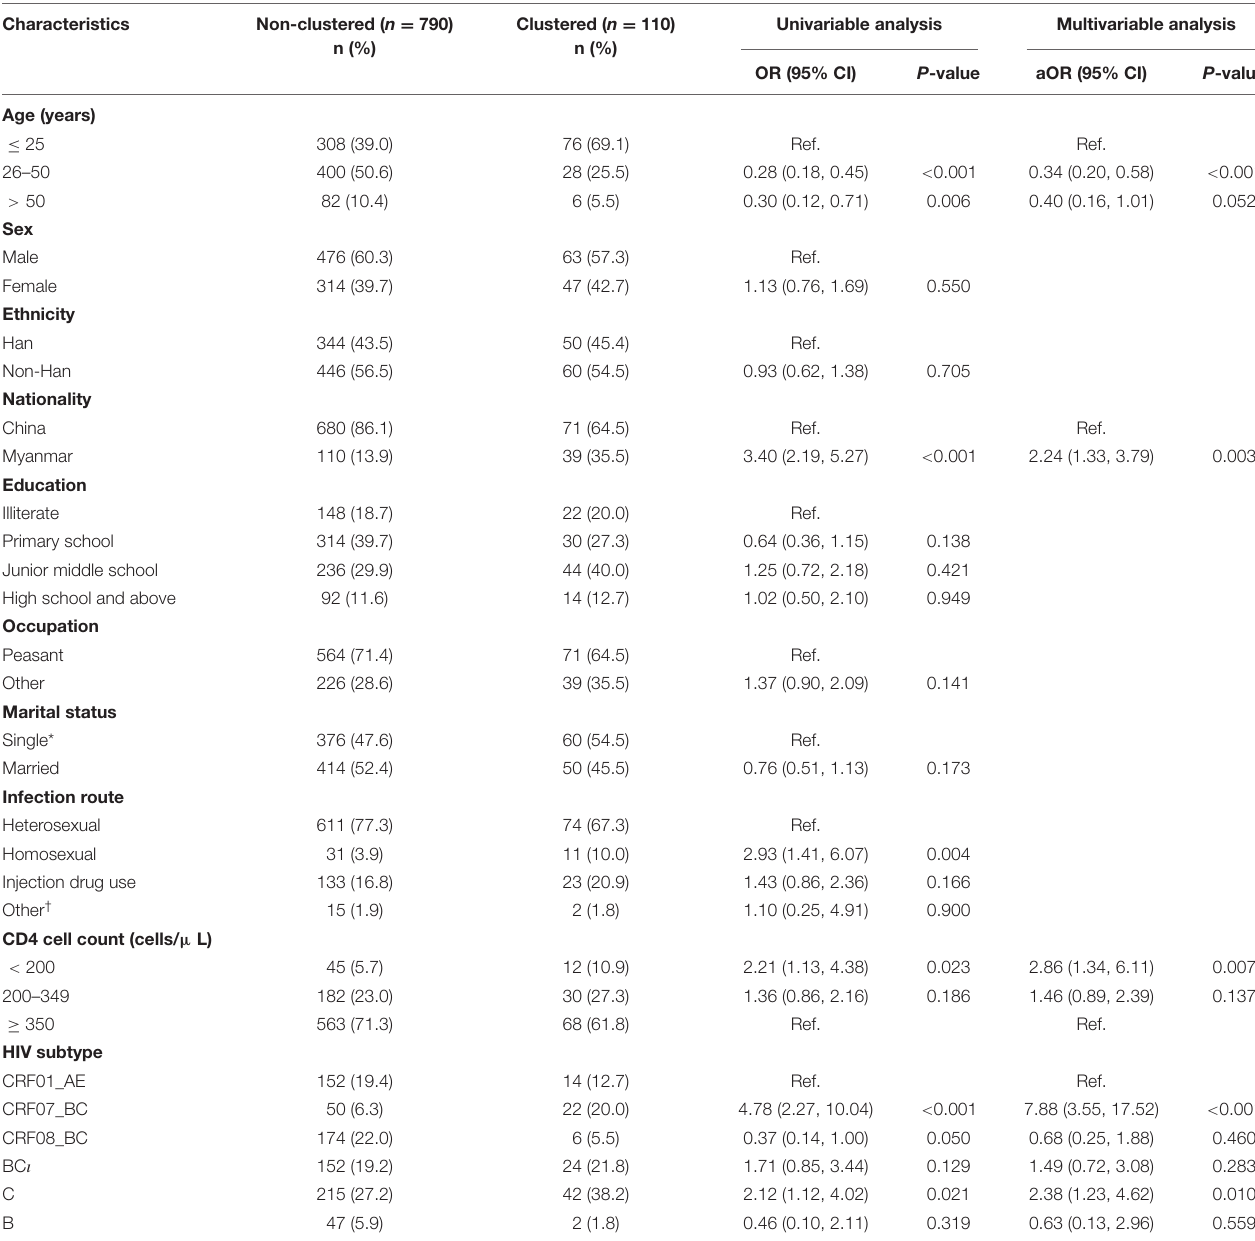
TABLE 3 | Univariable and multivariable logistic regression of factors associated with being grouped with a molecular transmission cluster (MTC).